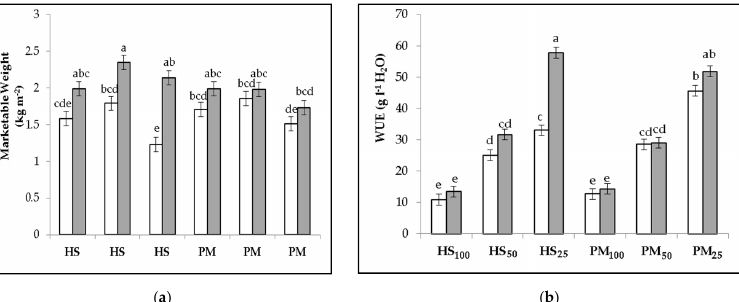
Figure 3. Experiment 3: E ff ect of irrigation strategy (HS 100 = recovery of 100% ET c calculated by the Hargraves–Samani equation; HS 50 = recovery of 50% ET c calculated by the Hargraves–Samani equation; HS 25 = recovery of 25% ET c calculated by the Hargraves–Samani equation; PM 100 = recovery of 100% ET c calculated by the Penman–Monteith equation; PM 50 = recovery of 50% ET c calculated by the Penman–Monteith equation; PM 25 = recovery of 25% ET c calculated by the Penman–Monteith equation) and mulching (white bars, no mulched, black bars, mulched) on soil-grown lettuce’s ( a ) marketable yield and ( b ) water use e ffi ciency (WUE, g FW L − 1 H 2 O). Vertical bars indicate SE, di ff erent letters indicate significant di ff erences with p ≤